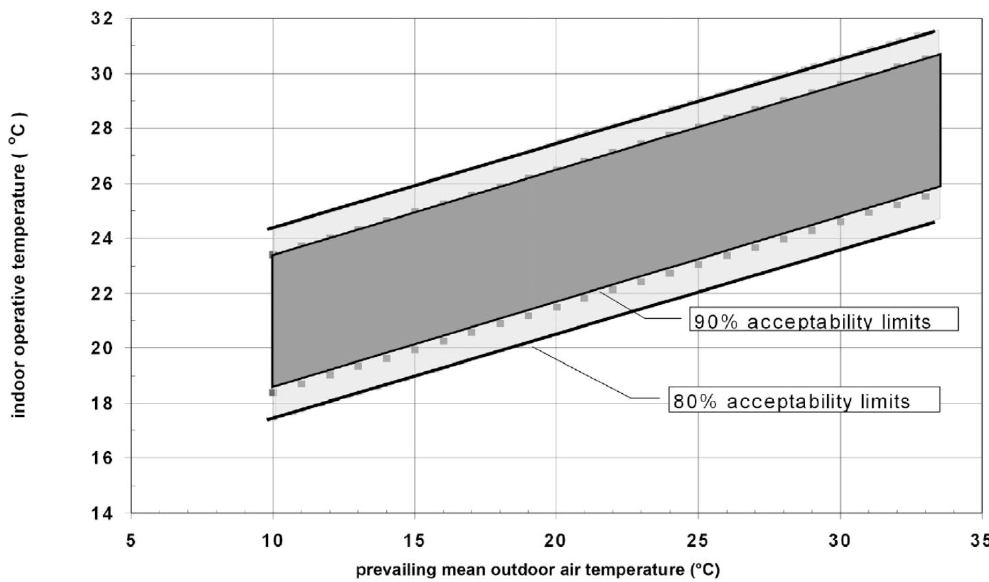
Figure 11. Acceptable operative temperature 6( T o ) ranges for naturally conditioned spaces.